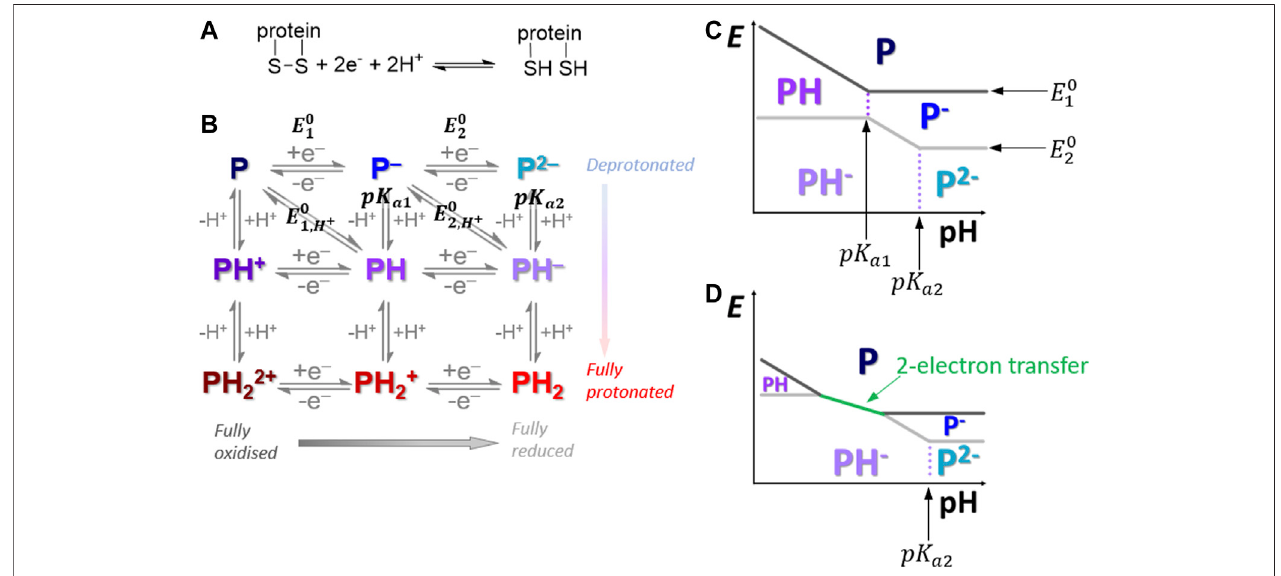
FIGURE 1 | (A) Overall disul fi de bond two-proton, two-electron oxidative-formation and reductive-cleavage reaction. (B) How the overall reaction separates into a square-schemeofverticalone-protonandhorizontalone-electrontransferswhere “ P ” denotestheproteinredoxcenter. (C,D) PourbaixdiagramsdepictinghowpHcan in fl uence the reaction pathway across the top half of the Pourbaix